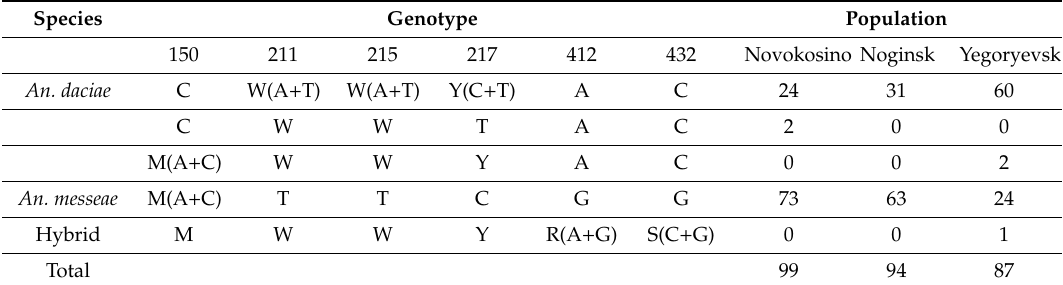
Figure 2. Examples of ITS2 sequence chromatograms for An. messeae ( A ), An. daciae ( B ), and their hybrid ( C ). Dash lines indicate positions of SNPs that distinguish the two species. Chromatograms indicate the presence of double picks in position 150 of An. messeae and in positions 211, 215, and 217 of An. daciae . The specimen with double picks in position 150, 211, 215, 217, 412, and 432 was identified as a hybrid between An. messeae and An. daciae . Table 1. Variations in ITS2 genotypes of An. messeae and An. daciae from three populations in the Moscow region.